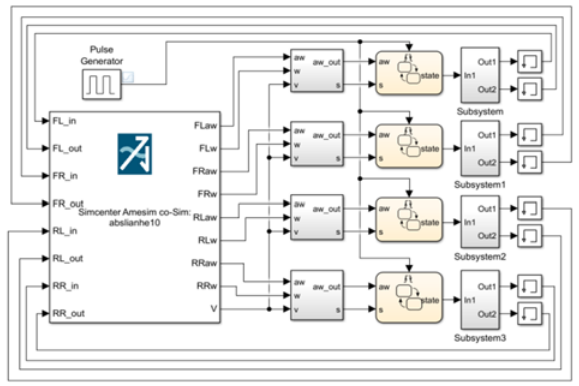
Figure 5. Controller submodel of the pneumatic ABS in Simulink.